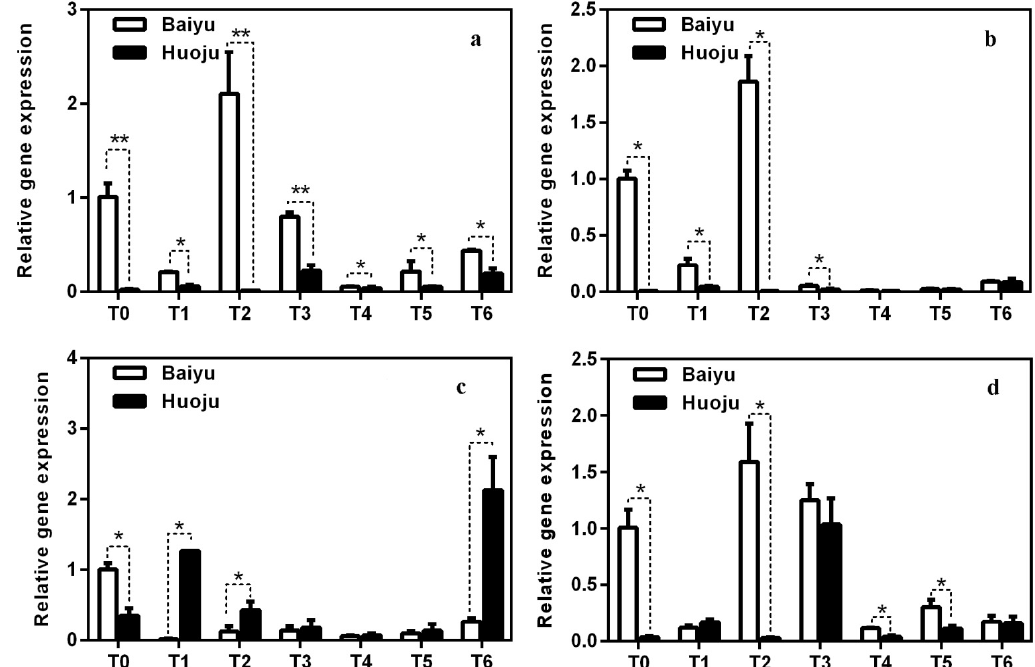
Figure 7. EjABH2 ( a ), EjABH4 ( b ), EjABH4-like ( c ), and EjABH4-like2 ( d ) expression during loquat bud differentiation. Note: T0–T6 in horizontal axis indicates sampling dates, i.e., 7–13, 7–19, 7–27, 8–03, 8–10, 8–17, and 8–24, respectively; * indicates significance at p ≤ 0.05; ** indicates significance at p ≤ 0.01; bars indicate standard error.